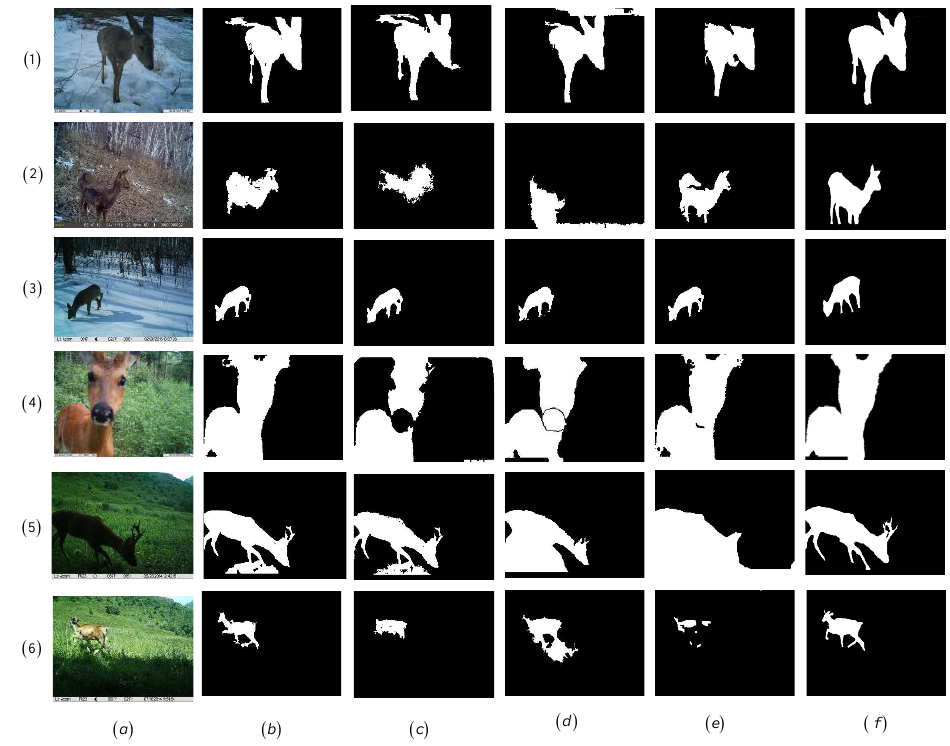
Figure 11. Vision comparison of wildlife image extraction: ( a ) the original image; ( b ) the extraction results of the proposed algorithm; ( c ) the extraction results of the N-cuts algorithm; ( d ) the extraction results of the aggregating super-pixels (SAS) algorithm; ( e ) the extraction results of the histogram contrast saliency detection (HCS) algorithm; and ( f ) ground-truth.